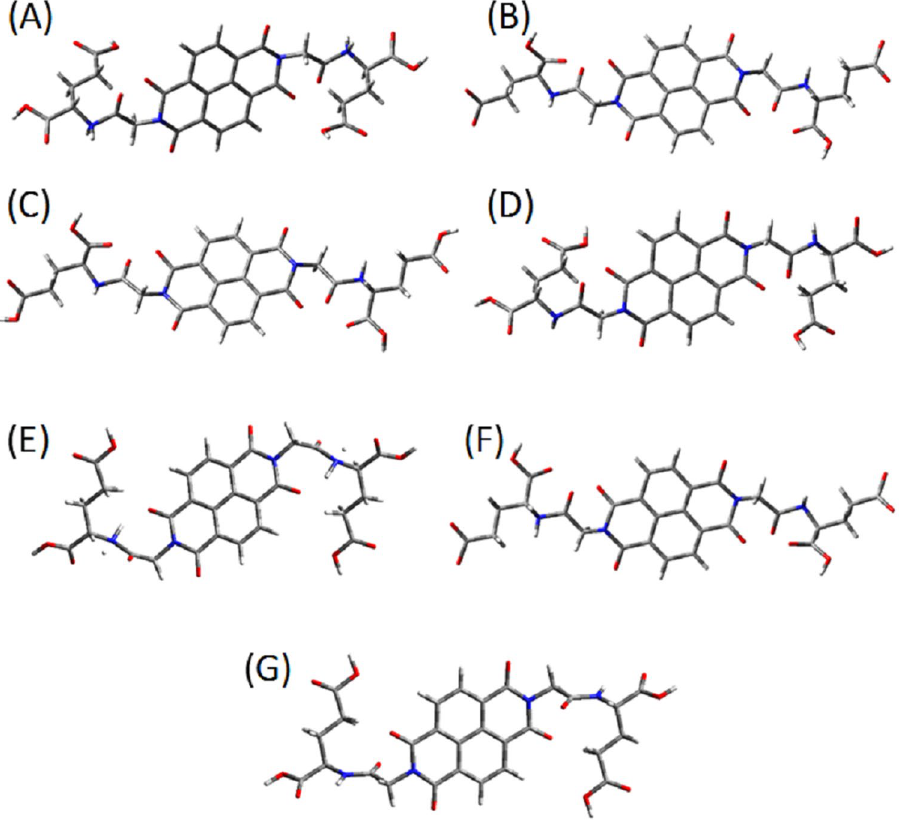
Figure 7. The initial molecular conformations of positively charged NDI-L-Glu ( 1 ) dication ( A ), negatively charged dianion ( B ), and neutral conformations ( C and D ) considered for geometrical optimization. The optimized ( E ) dication, ( F ) dianion and ( G ) neutral NDI-L-glu molecular conformations as calculated using DFT B3LYP/3–21 G level of